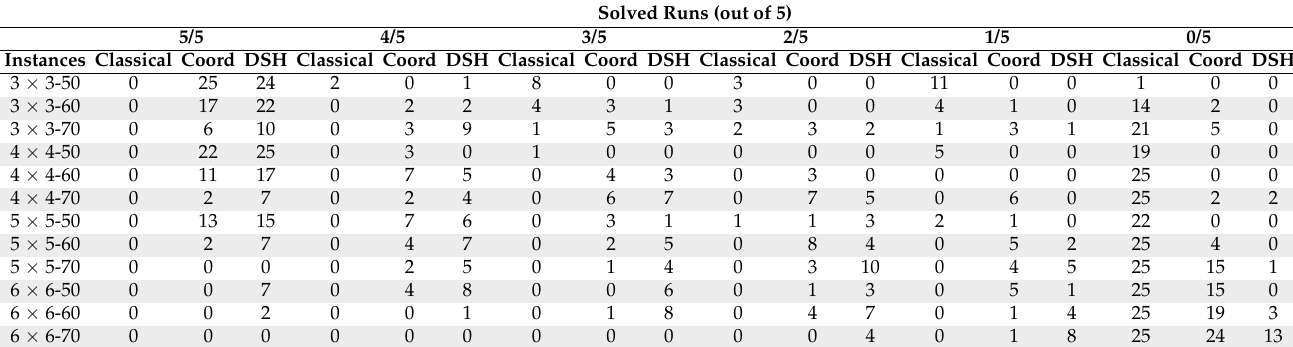
Table 2. Overview of solved runs (up to five) for the 25 instances per instance set for the different synthesis